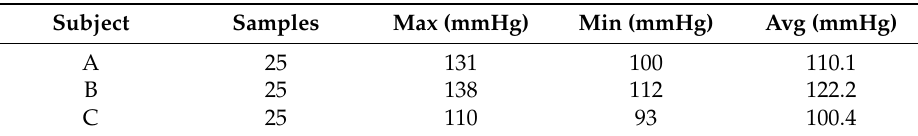
Table 2. Validation data set of each subject.